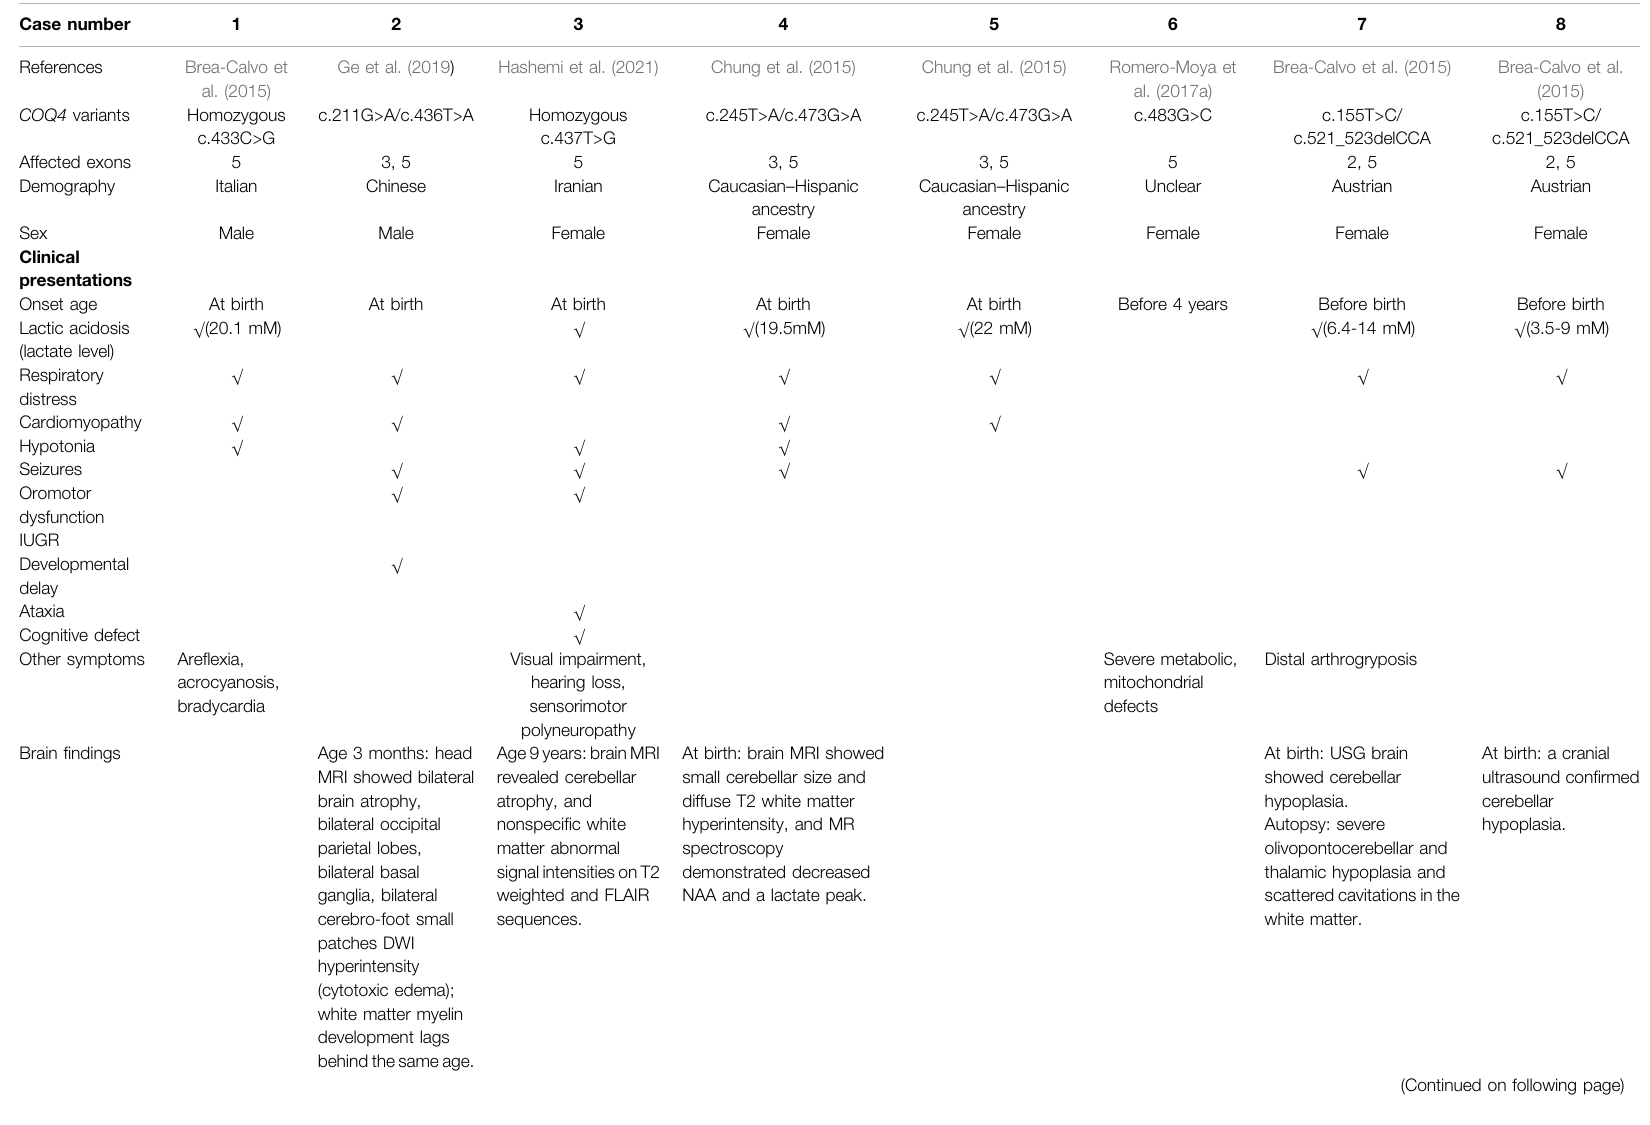
TABLE 2 | Clinical presentation, treatment, outcomes, and brain fi ndings for patients with COQ4 variants in exons